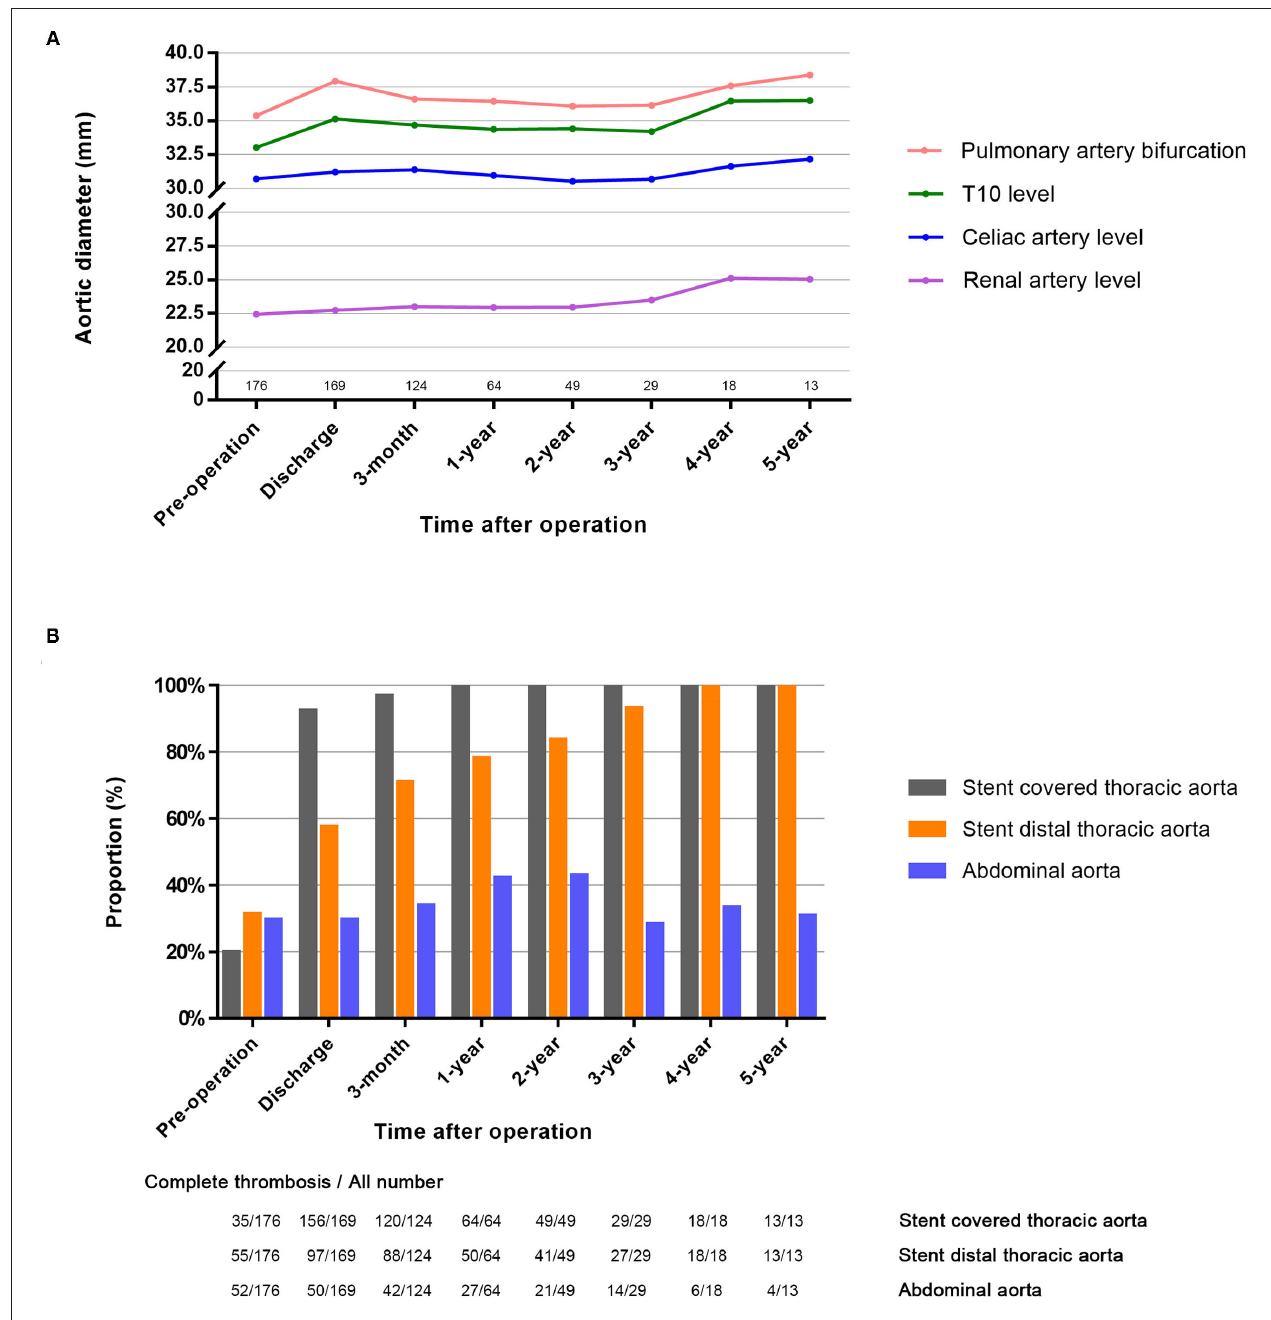
FIGURE 5 | Outcomes of radiographic analysis. (A) Aortic diameter changes during the follow-up: the aortic diameter was stable during the follow-up in the descending aorta of pulmonary artery bifurcation, Th10, celiac artery and renal artery level. (B) Complete thrombosis of false lumen during the follow-up.